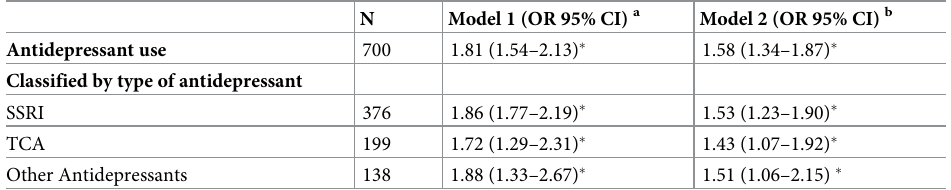
Table 1. Association between antidepressant use and fall occurrence in past 12